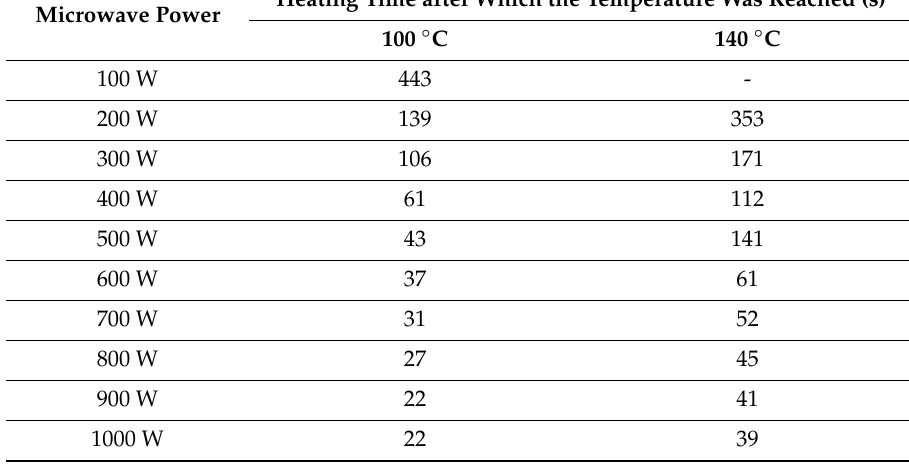
Table 4. Summary of durations of microwave heating of a 70 mL distilled water sample. Source: Experimental data achieved in the MSS3 reactor (IHPP